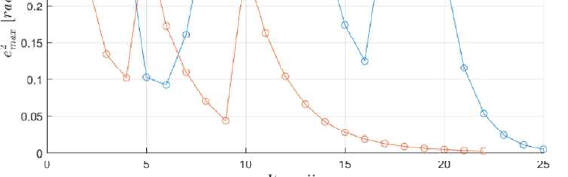
Figure 12. Maximum error norm